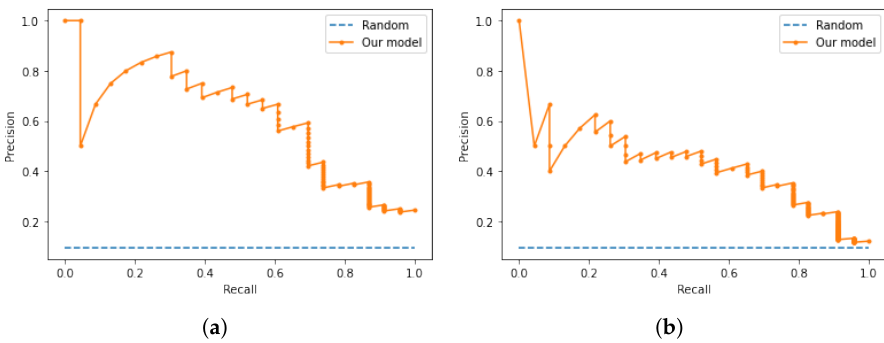
Figure 5. PR curves for the test dataset. ( a ) 24 h ahead prediction, ( b ) 48 h ahead prediction. Table 1. Various performance indices for 24 and 48 h ahead predictions based on the test dataset. Forecasting Threshold Recall Precision